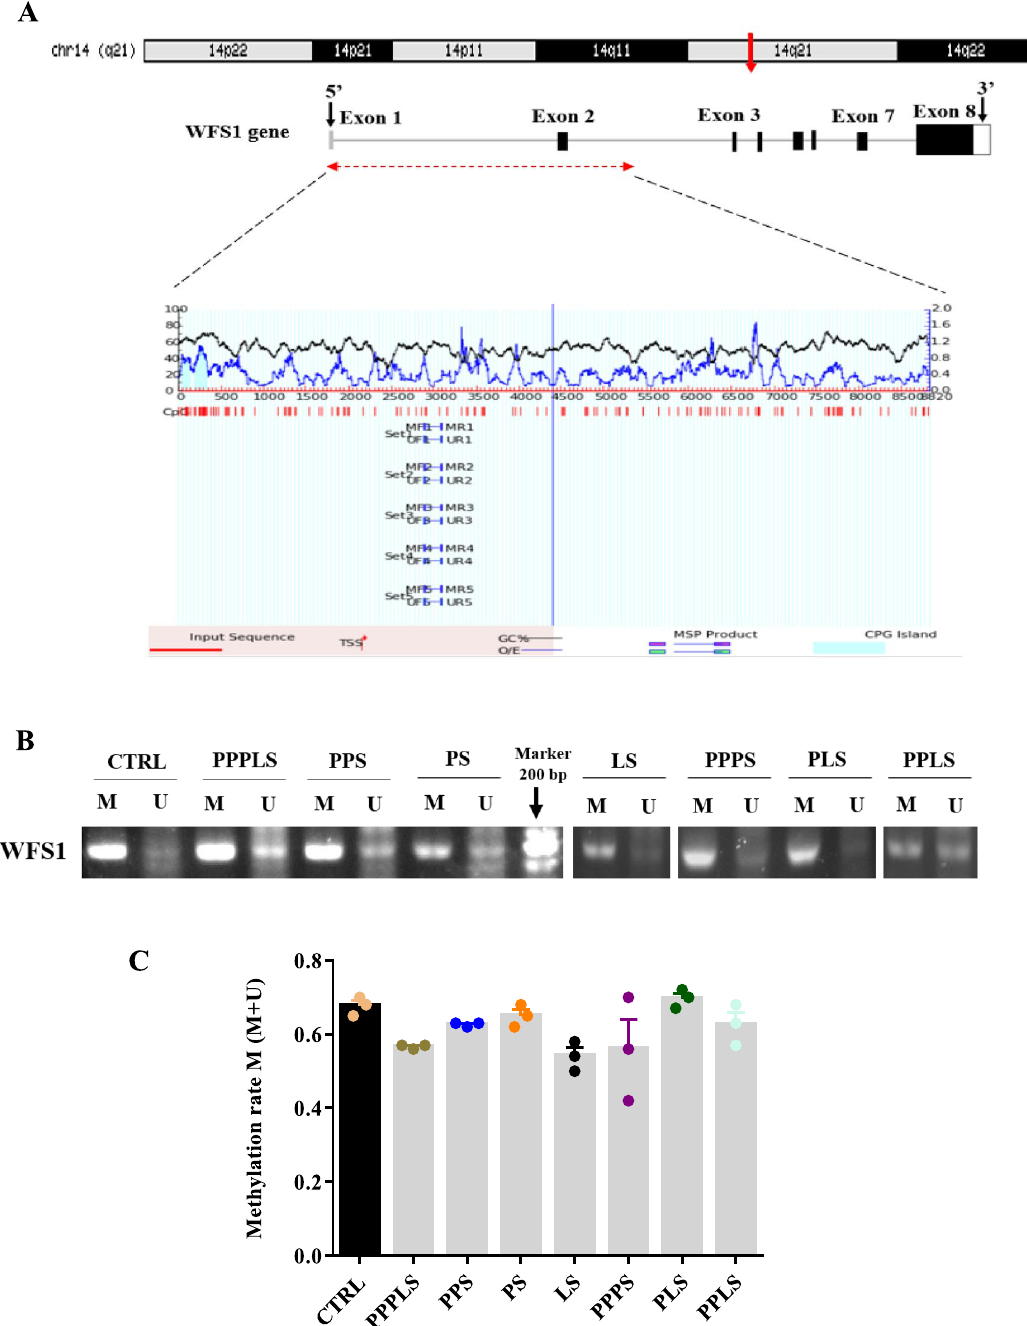
Figure 7. Effect of perinatal stress on DNA methylation of WFS1 gene in pancreatic tissue. Schematic presentation of promoter area of the WFS1 gene encompassing investigated CpG Island ( A ). Agarose gel electrophoresis demonstrating the methylation status of WFS1 promoter in pancreatic tissue by methylation- specific PCR (MSP). Primer sets used for amplification are designated as un-methylated (U), and methylated (M) ( B ). Each column represents mean ± SEM (3 rats/group, 3 litters/group). CTRL non stress, PPPLS pre- pregnancy, pregnancy, lactation stress, PPS pre-pregnancy stress, PS pregnancy stress, LS lactation stress, PPPS pre-pregnancy, pregnancy stress, PLS pregnancy, lactation stress, PPLS pre-pregnancy, lactation